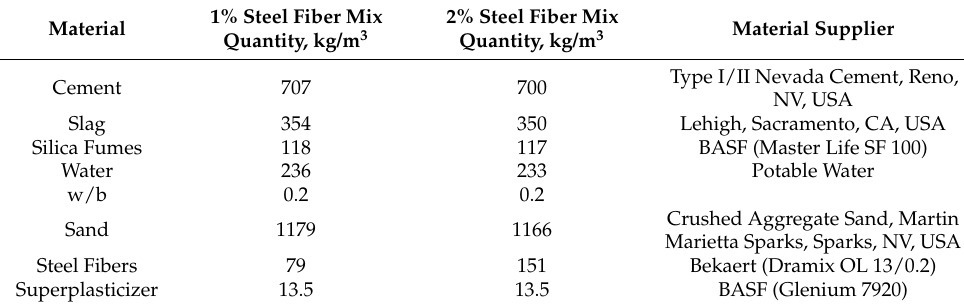
Table 1. Mixing Proportions and Material Sources of the NP-UHPC Mixes.